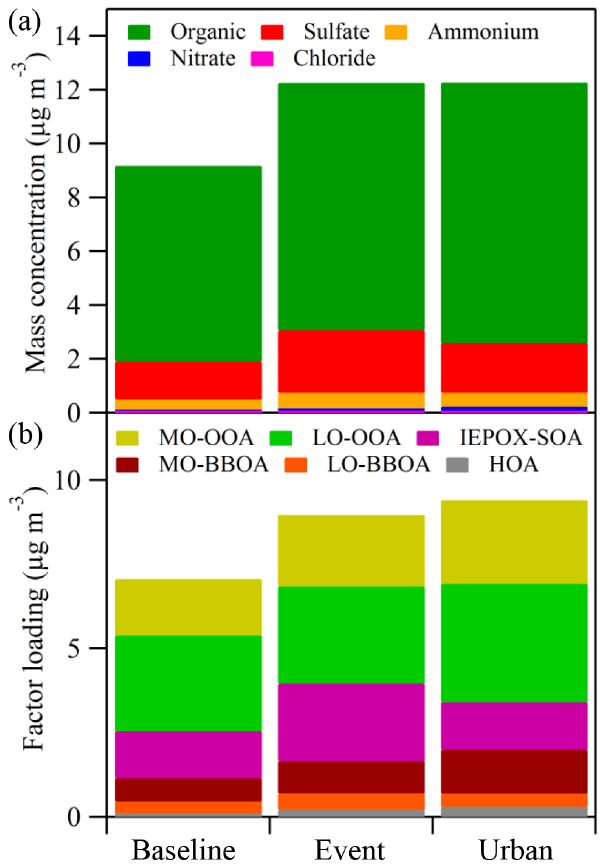
Figure 10. PM 1 characterization represented by the centroids of the FCM clusters. (a) Mass concentrations of AMS species. (b) PMF factor loadings. Results are for afternoon time periods. Table S1 lists the values presented in this